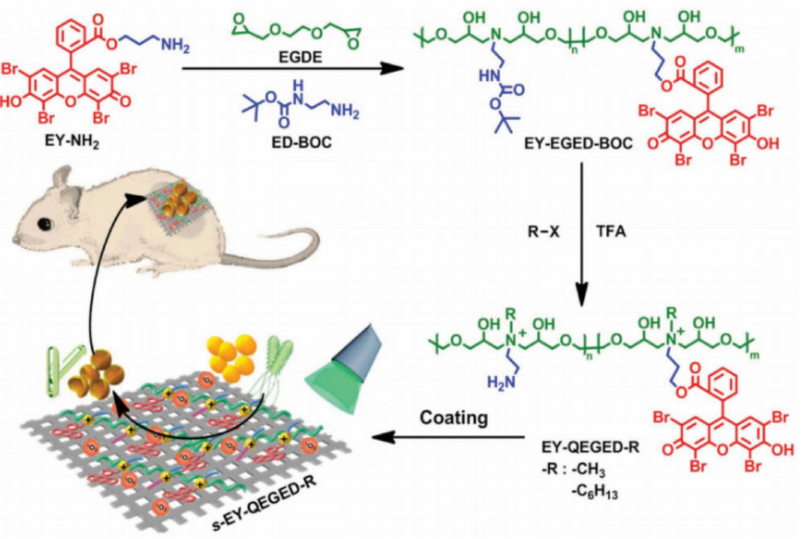
Figure 6. Schematic illustration of synthetic route of polycationic antibacterial agents with multiple functional components and a proof-of-concept application as a wound dressing material